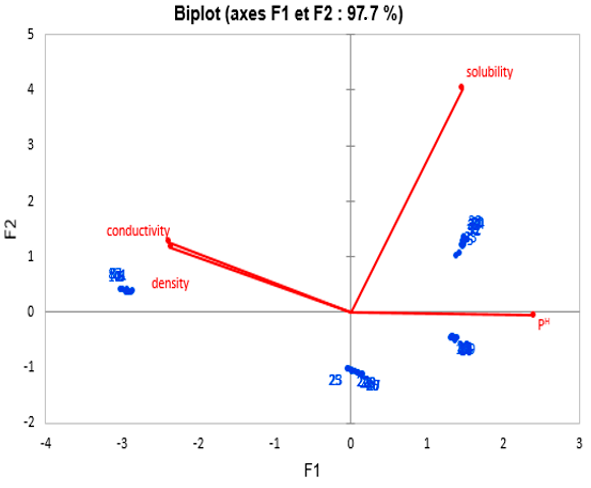
Figure 2. Representation of variables and tests in the plane of the main component.